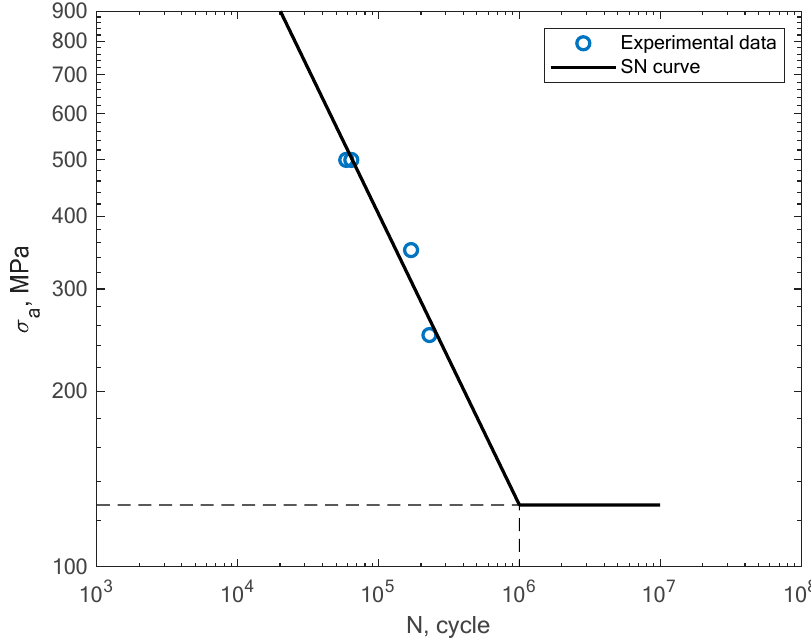
Figure 19. S–N curve for the experimental tension–compression (R = 0) fatigue test results reported by Gatto et al. [5] for the case of non-zero mean stress.